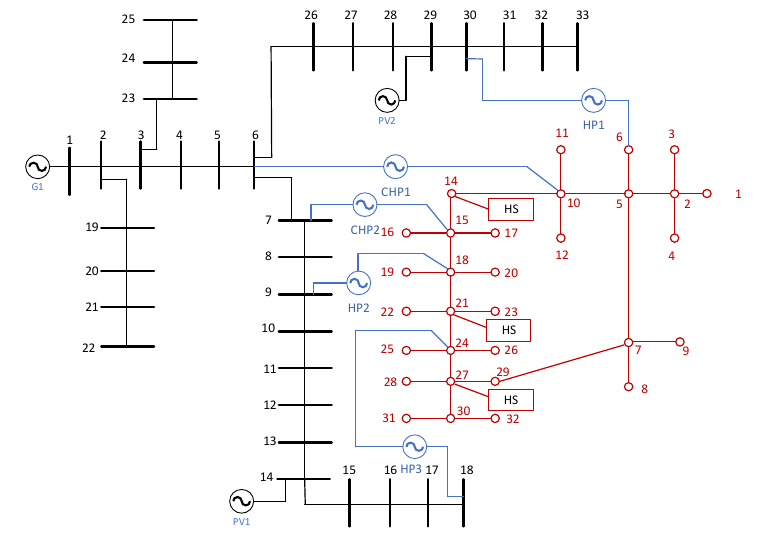
Figure 6. Topology of the test system.